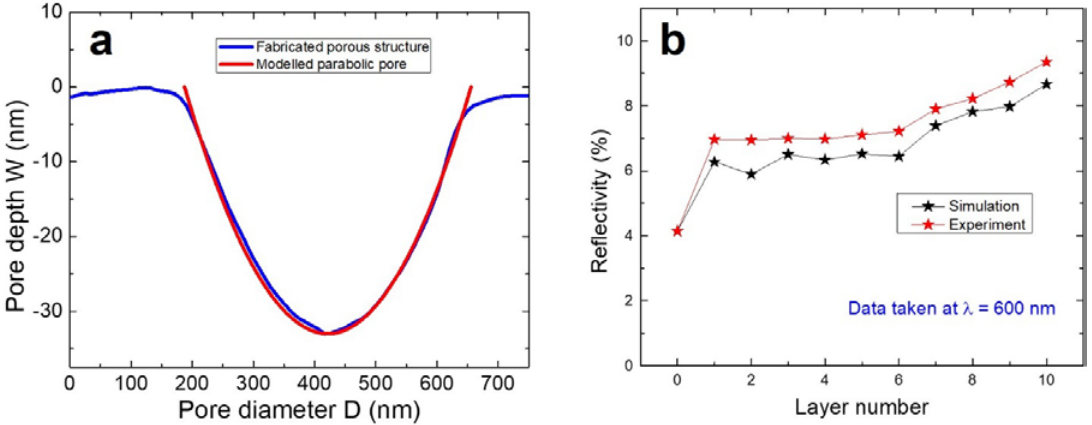
Figure 3. ( a ) Parabolic-shaped pore depth versus diameter plot obtained using Equation (1) ( z = cx 2 ) aligns well with observed pore shapes as determined using the line profile AFM data for a 10-layer biofilm. ( b ) Experimental and modeled reflectance values obtained at λ = 600 nm for a 10-layer biofilm.